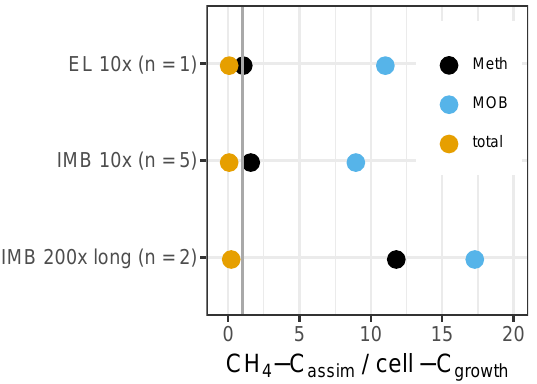
Figure 8. Ratio of methane-carbon assimilated (CH 4 -C assim ) to cell-C gained during growth (cell-C growth ), based on flow cytomet- ric cell counts (total) or inferred cell numbers (Meth, MOB). The standard deviation between replicates was 10 to 20%. The verti- cal line indicates a ratio of 1. Above 1, the entire cell gain can be explained by the assimilated CH 4